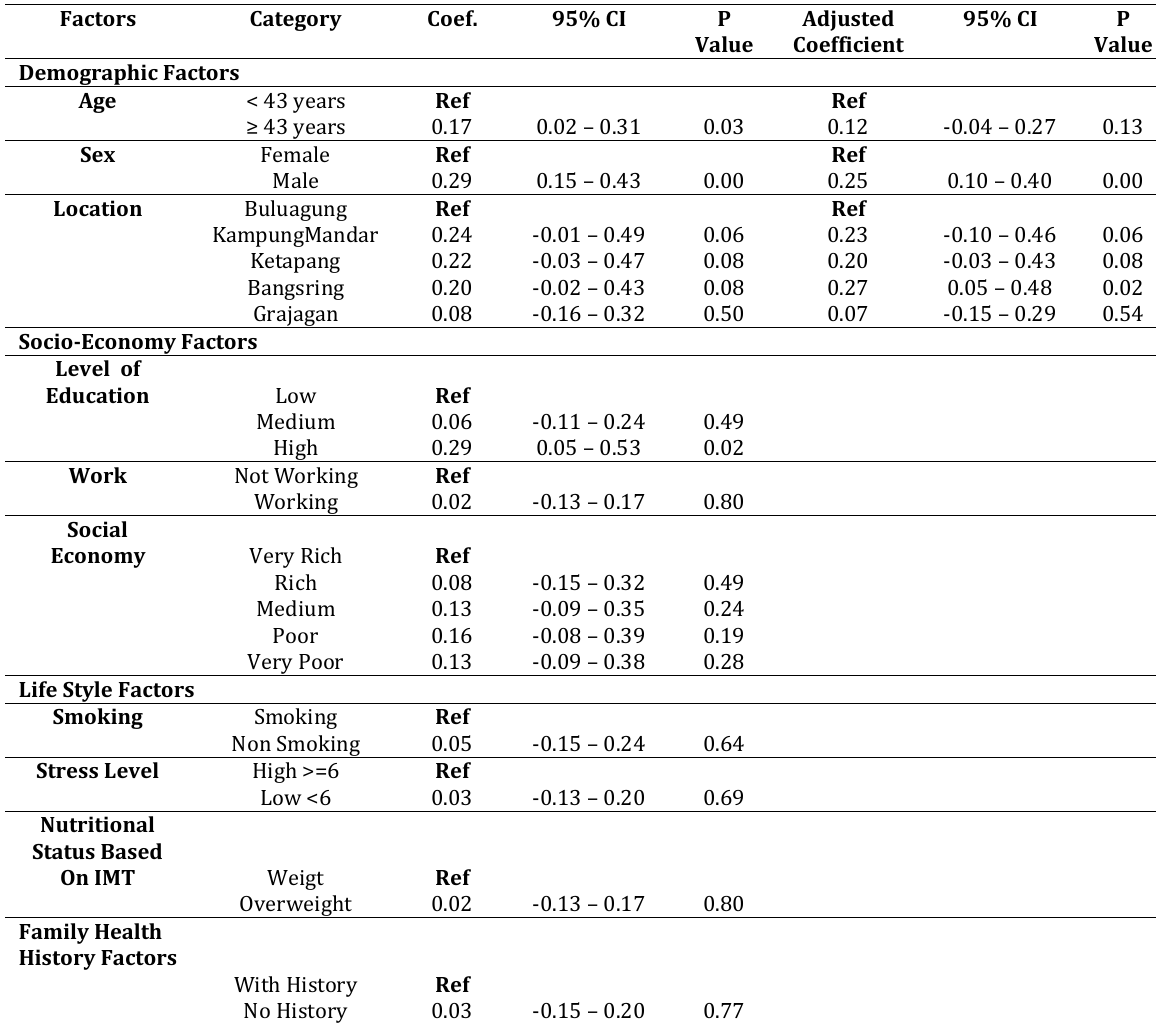
Table 2. Determinants of Increased Random Blood Glucose Levels